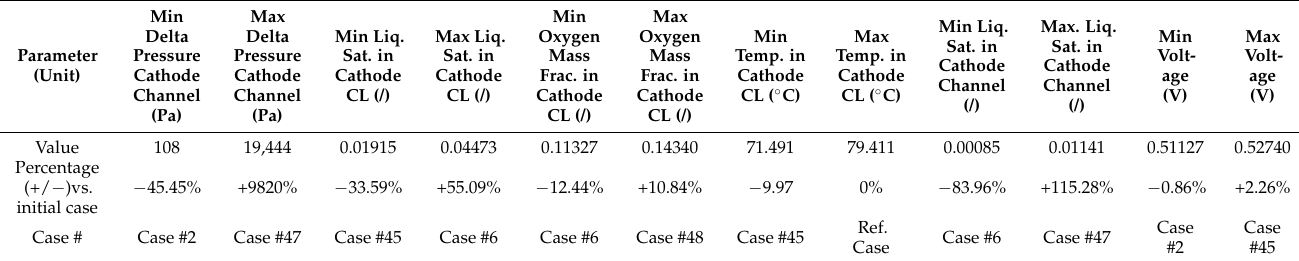
Table 7. Comparison of cases with min and max values of parameters of interest at current density of 4.0 A · cm − 2 vs. the ref.